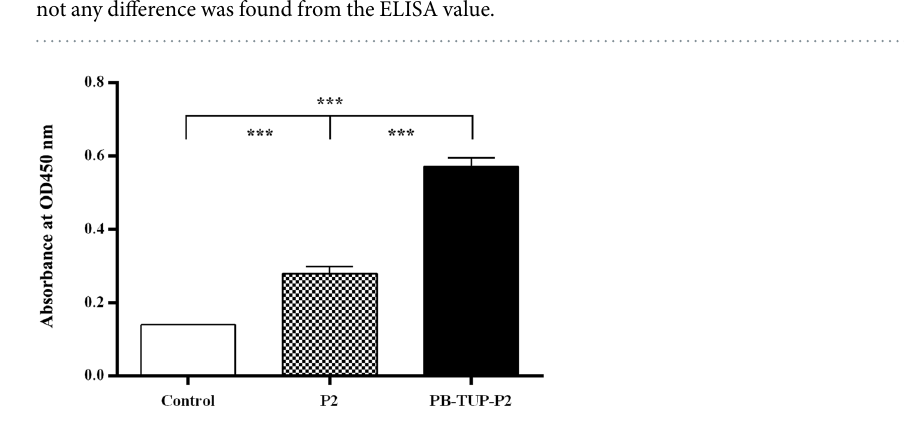
Figure 9. HUVECs adhesion assay of P2 and PB-TUP-P2. Polystyrene 96-well cell culture plates were coated with P2 or PB-TUP-P2 at a concentration of 75 μ M and saturated with 1% BSA. HUVECs were seeded at a density of 2 × 10 4 cells per well. The adhered cells were measured by cck-8 kit. The number of HUVECs bound to PB-TUP-P2-coated wells showed a very significant difference from that of P2-coated wells. Fusion with PB- TUP did not affect the interaction between P2 and